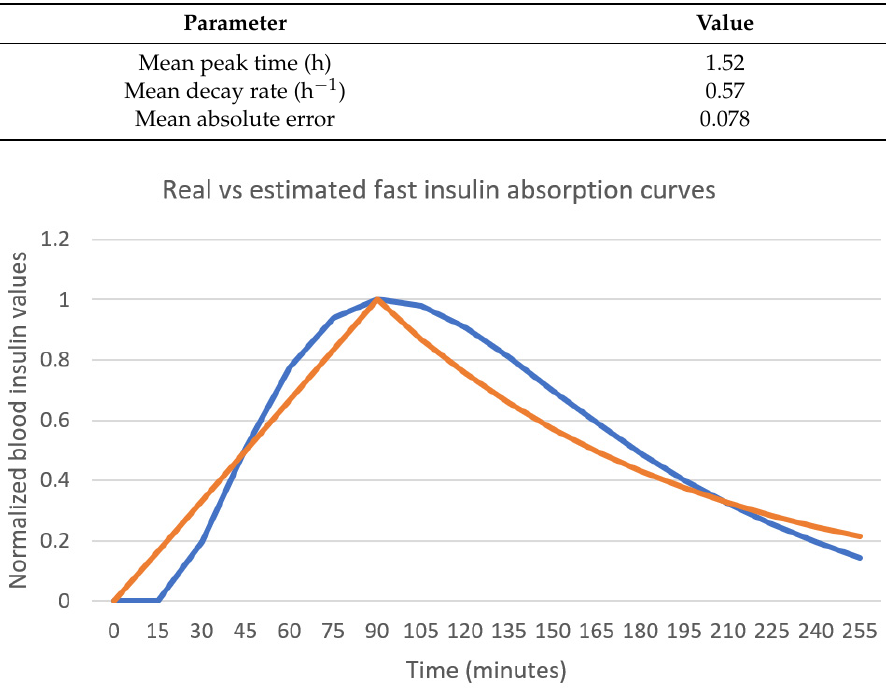
Figure 5. Real vs. estimated fast insulin curves.